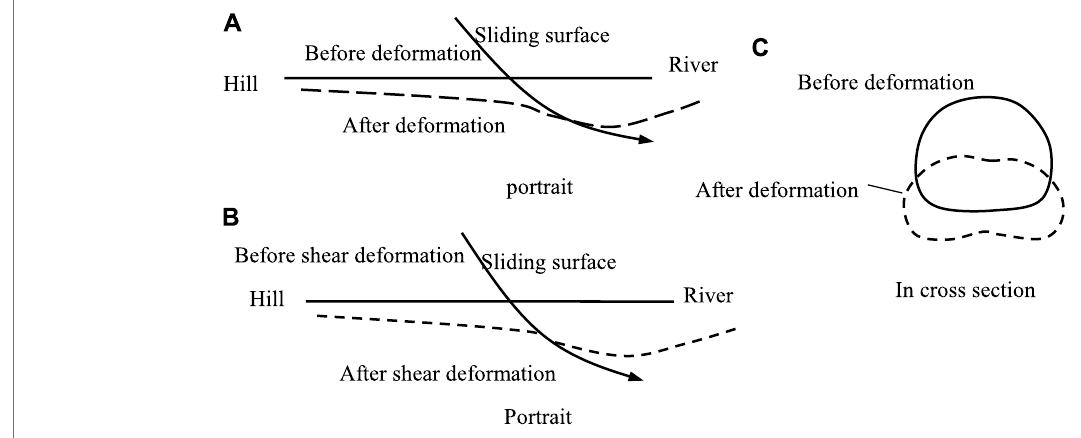
FIGURE 11 | Deformation diagram of the “ longitudinal shear ” mode.